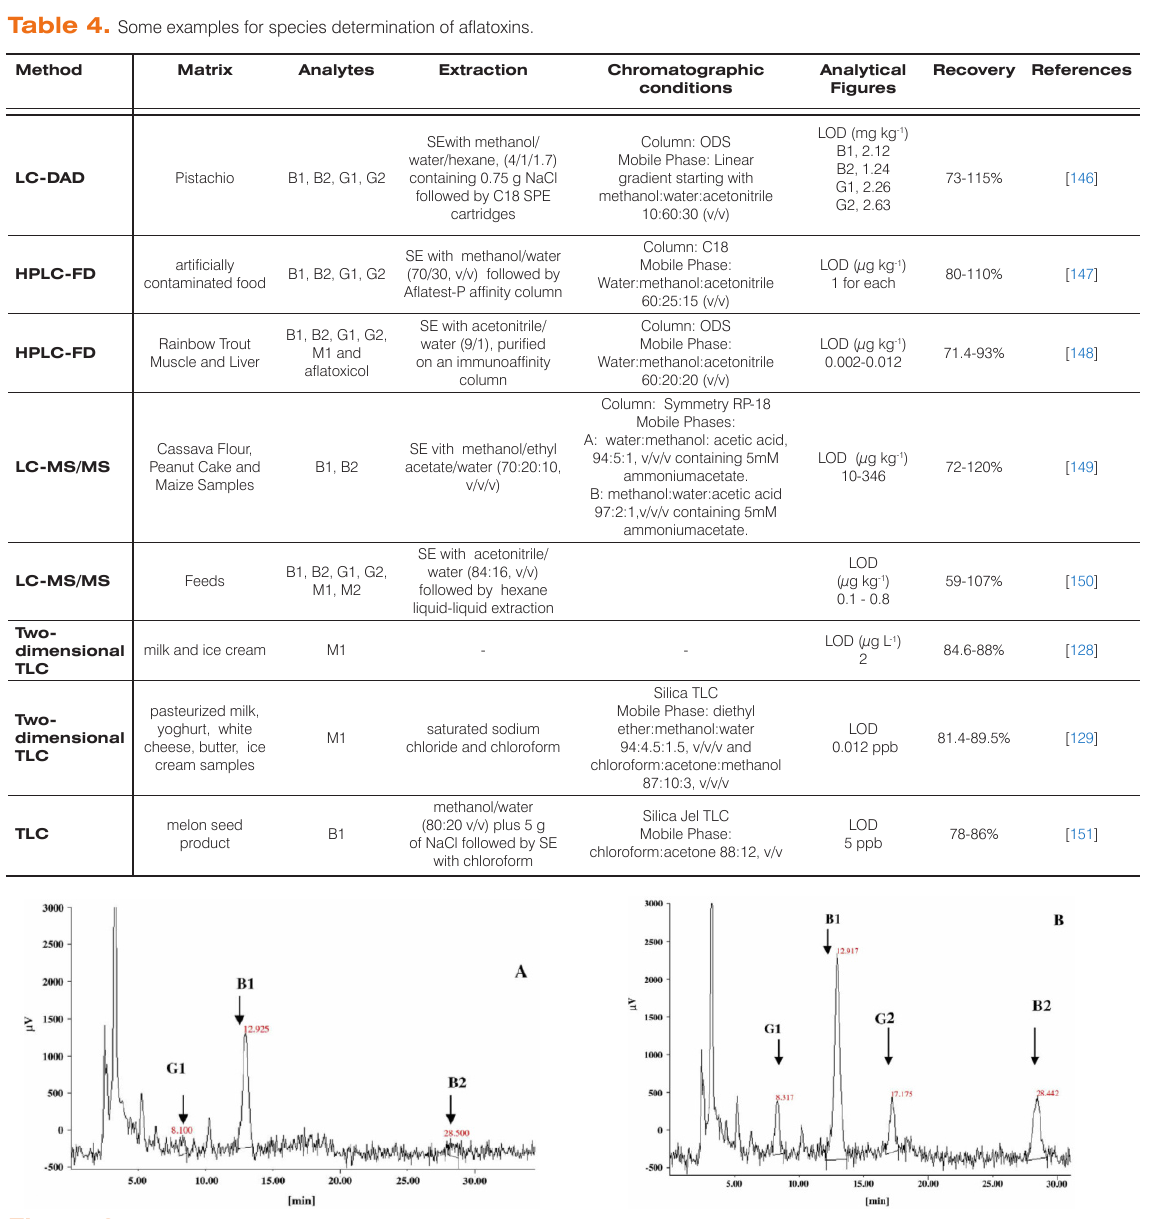
Figure 2. Chromatograms of animal feed sample (A) and sample with spiked aflatoxins